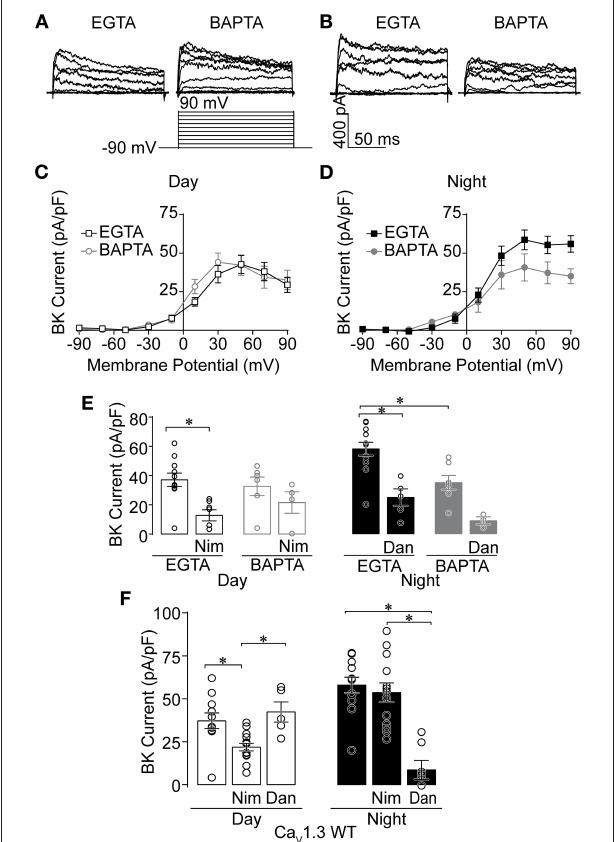
FIGURE 1 | Effects of Ca 2 + chelators and Ca 2 + channel inhibitors on BK currents recorded from SCN neurons during the day and night. Paxilline-sensitive macroscopic BK currents were recorded from C57BL6 WT (A–E) and Ca V 1.3 WT (F) SCNs. All intracellular solutions in this study were made with 0.9mM EGTA, except where 5mM BAPTA was substituted (A–E) . Currents were elicited from a holding potential of − 90mV by 150-ms voltage steps from − 110 to + 90mV in + 20-mV increments. (A,B) Representative BK currents from − 90 to + 90mV are shown from day (A) and night (B) SCN neurons. (C,D) Current-voltage plot comparing BK current density recorded in either control EGTA or BAPTA during the day (C) and night (D) . (E) Summary of BK current density at + 90mV recorded with control EGTA or BAPTA